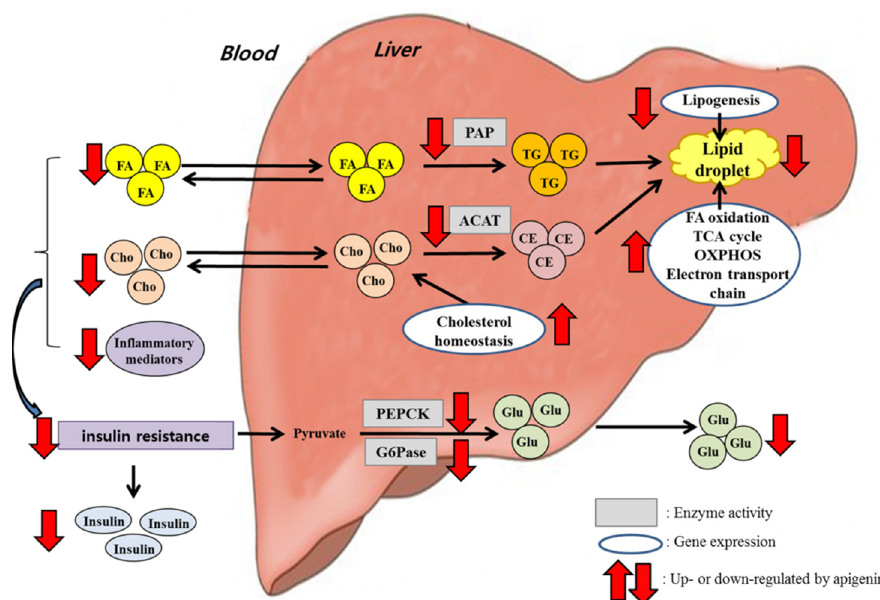
Figure 6. Schematic diagram showing the mechanisms underlying the beneficial effects of apigenin on obesity-related metabolic disturbances. Apigenin decreased the activities of hepatic enzymes controlling triglyceride synthesis and cholesterol esterification and increased the expression of hepatic genes involved in fatty acid oxidation, the TCA cycle, OXPHOS, the electron transport chain and cholesterol homeostasis while decreasing the expression of hepatic lipogenic and lipolytic genes, indicating that these changes may be potential mechanisms for improving dyslipidemia and hepatic steatosis in HFD-fed mice. Moreover, apigenin decreased plasma pro-inflammatory adipocytokines levels and hepatic gluconeogenic enzyme activities, which may be partly associated with the improved hyperglycemia, hyperinsulinemia and insulin